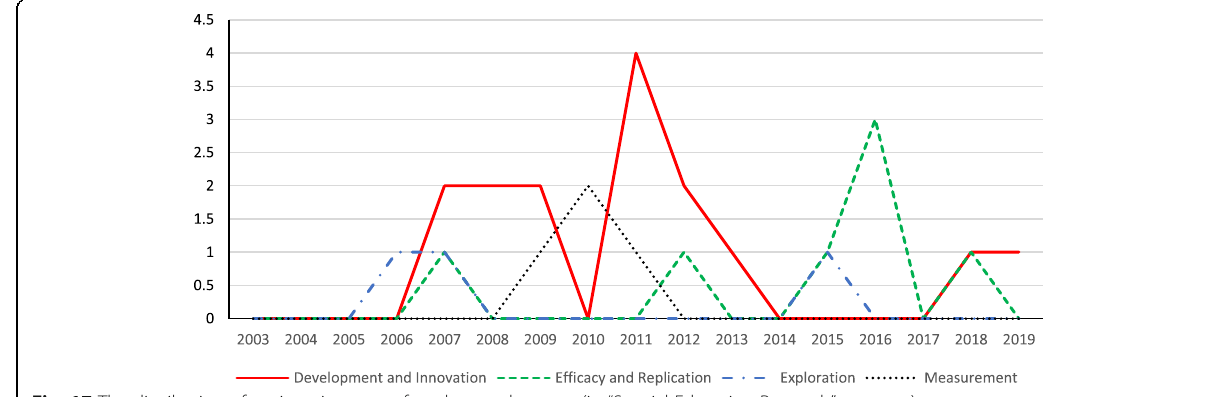
Fig. 17 The distribution of projects in terms of goals over the years (in “ Special Education Research ”